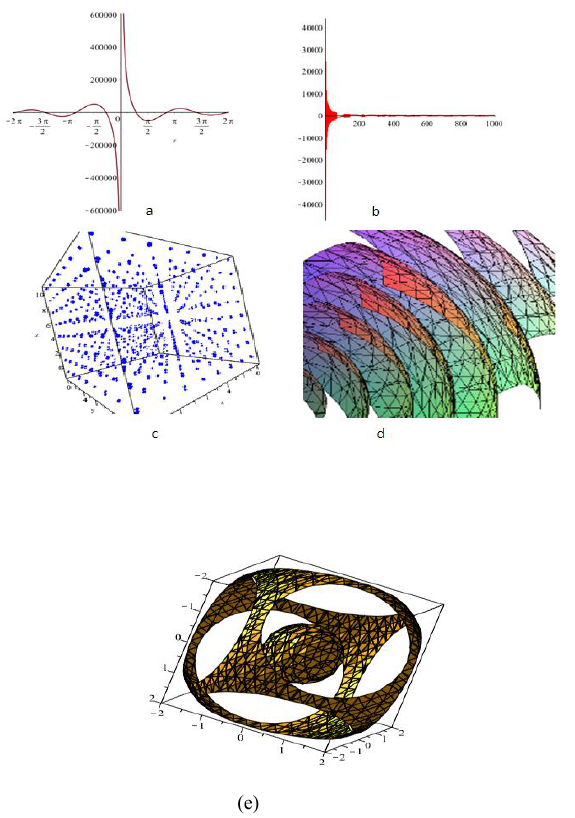
Figure 2: Input wave and simulated scattered wave plots using Maple: (a) Real part of incident wave 𝐸 0 (b) variation of incident electric field 𝐸 0 with r in nm (c) Scattered EM field (simulation of equation 39) (d) Wavefront of the scattered signal due to perturbed electric field 𝐸 2 ( THz ) (simulation of equation 42) (e) 3D plot of 𝐸 2